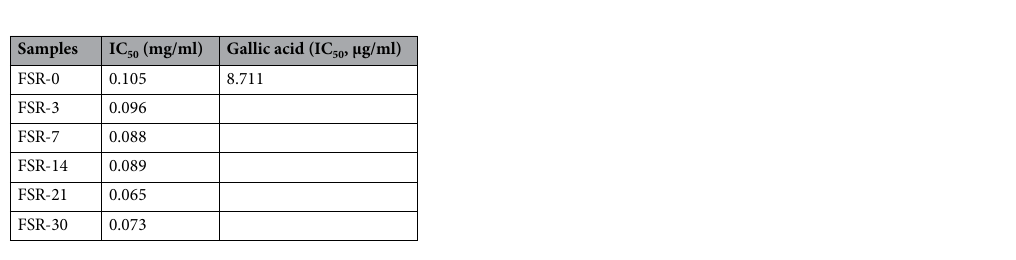
Table 3. IC 50 values for DPPH radical scavenging by fermentation solution of Rosa ‘Dianhong’ (FSR).